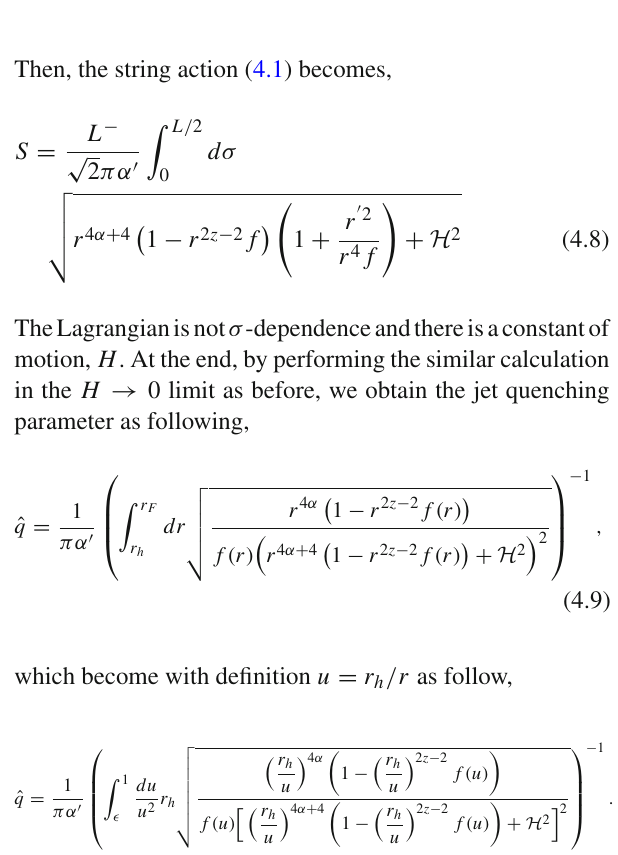
Fig. 5 Jet-quenching versus temperature in different H at z = 2, θ = d − 1 and Q =